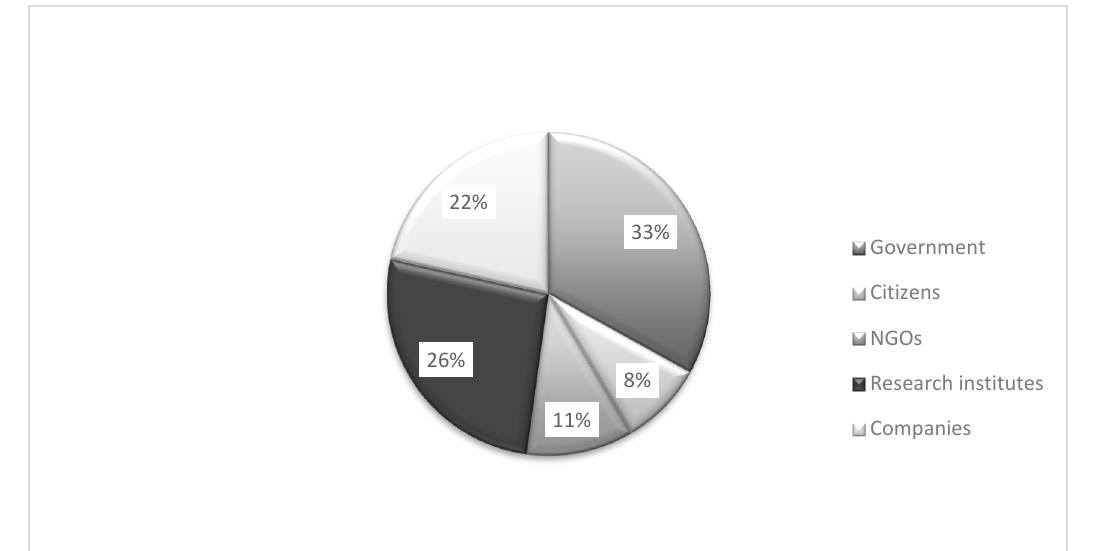
Figure 4. Number of tools found for each stakeholder.